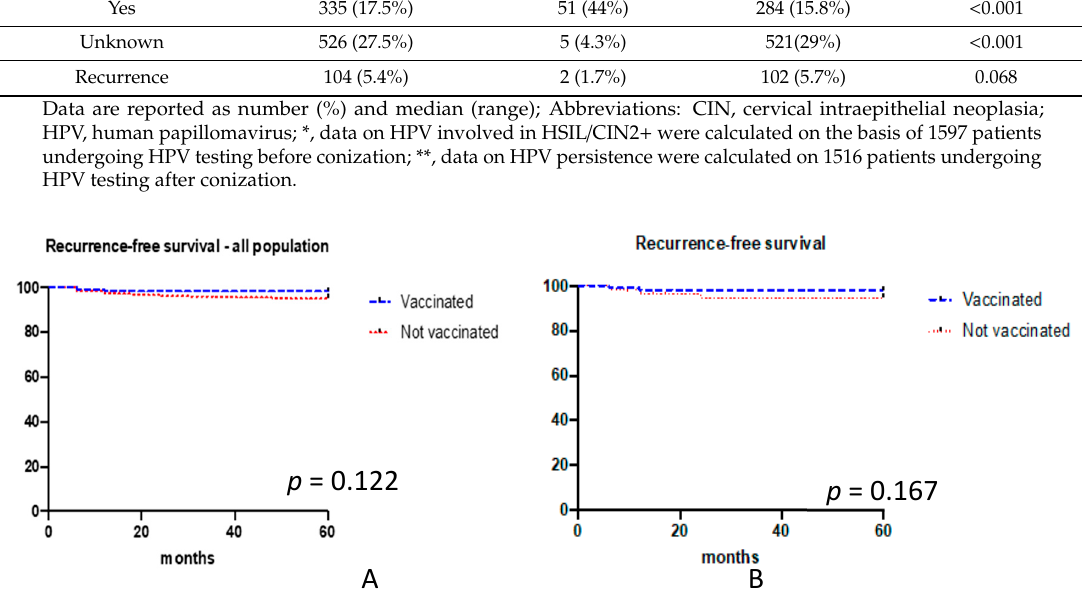
Figure 2. Five-year recurrence for women undergoing conization plus vaccination vs. conization alone ( A ) and five-year recurrence in the propensity-matched comparison cohorts ( B ).